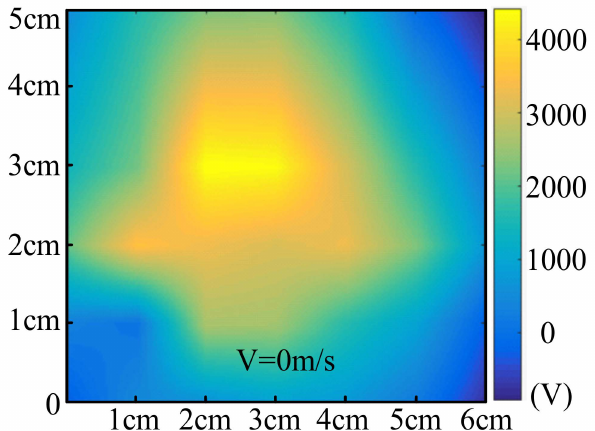
Figure 13. Charge distribution in the no airflow case.